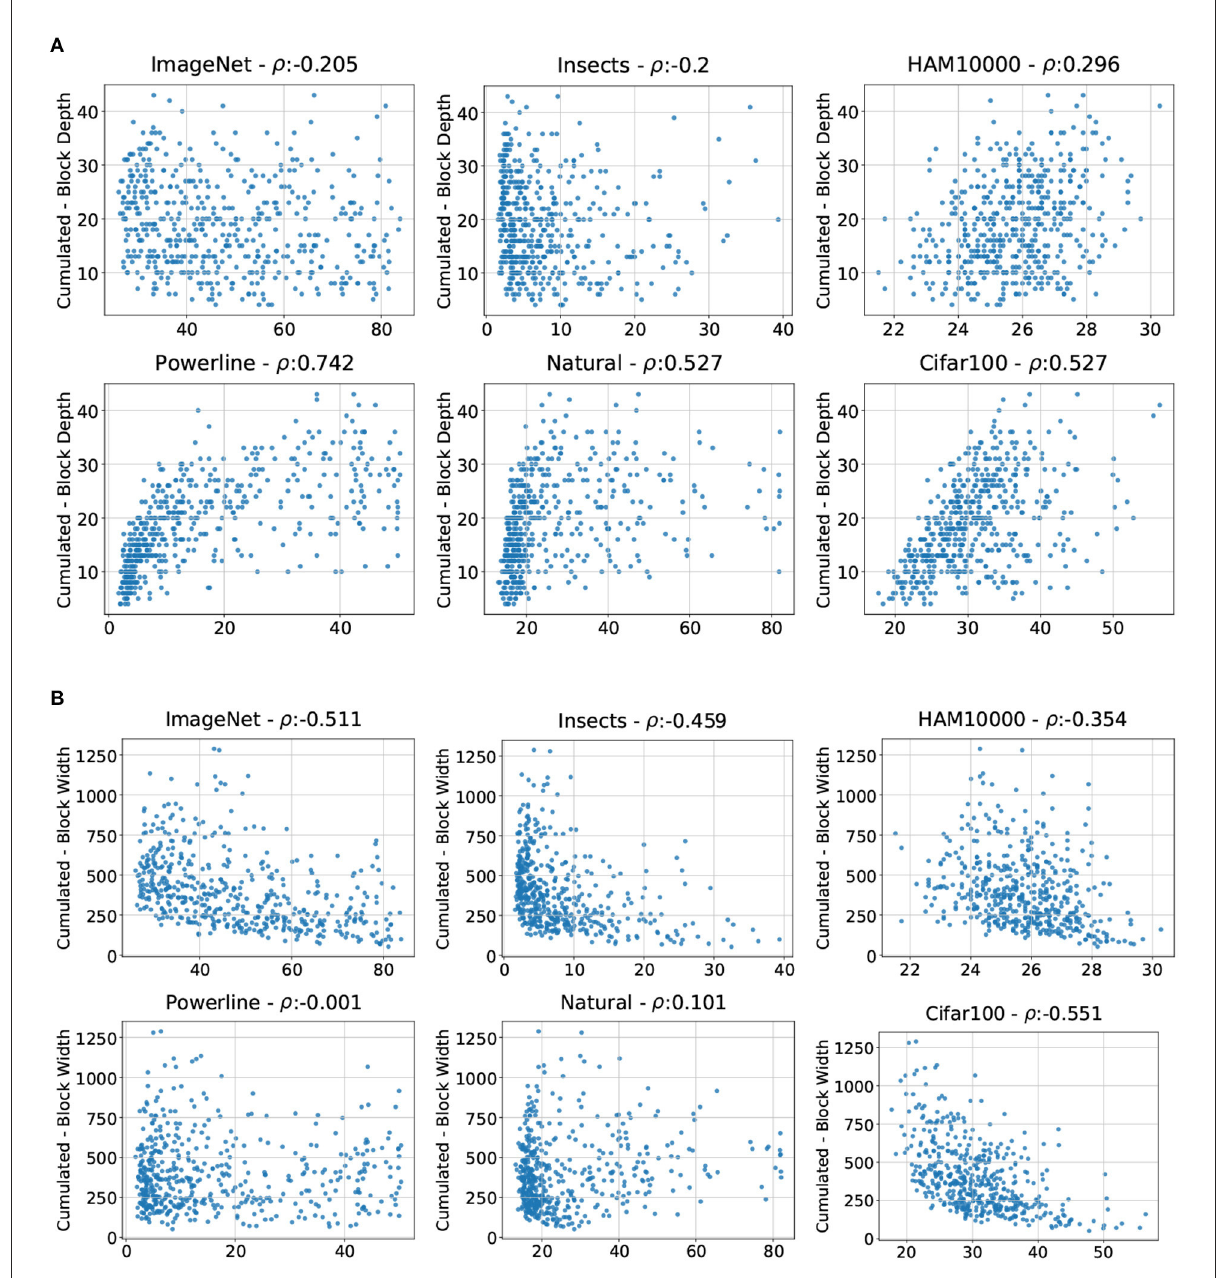
Table 4 contains the correlations between cumulative block depth/width and the errors on all members of ImageNet-X. With decreasing number of classes, the correlation coefficients increase for cumulative block depth and cumulative block